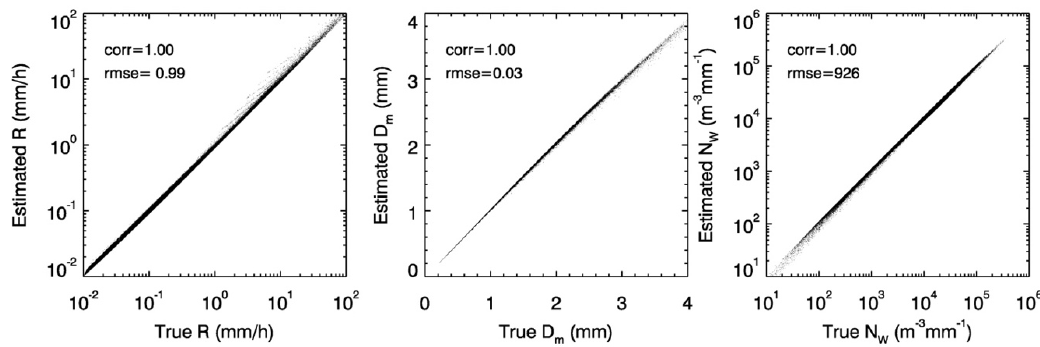
Figure 4. Scatter plots of the estimates in R ( left ), D m ( middle ) and N w ( right ) and their respective true values. Correlations between the estimates and truth and rms errors of the estimates, denoted by ‘corr’ and ‘rmse’, respectively, are also given.